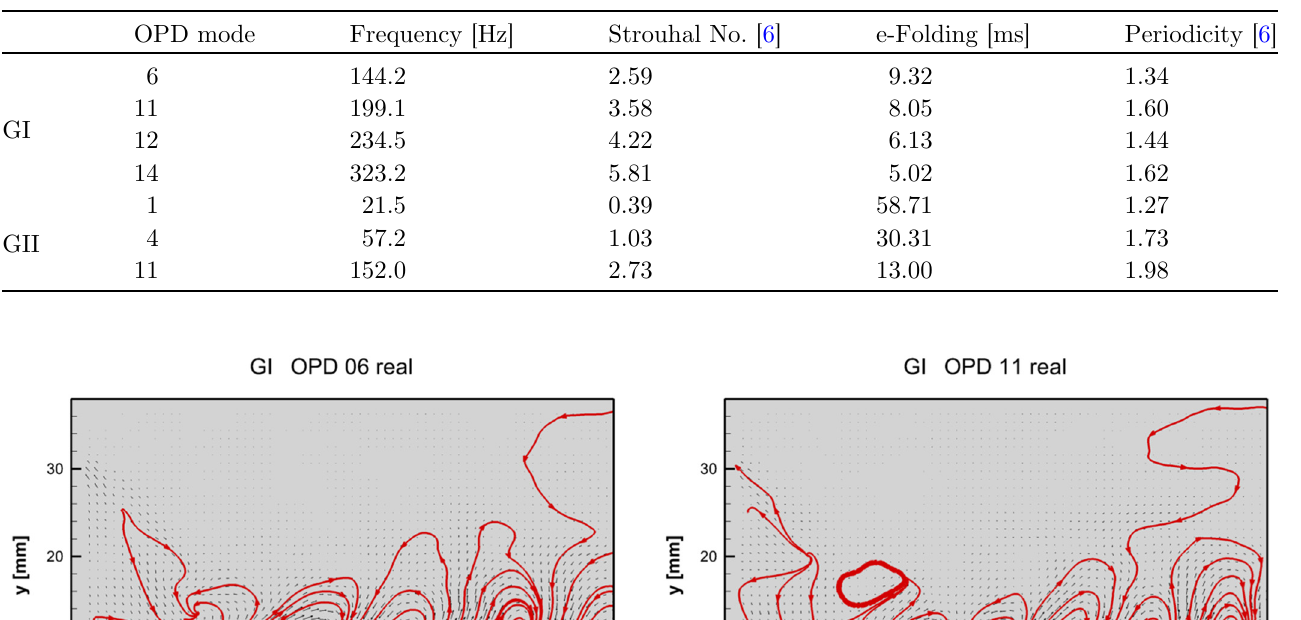
Table 2. Selected OPD modes, branch G.